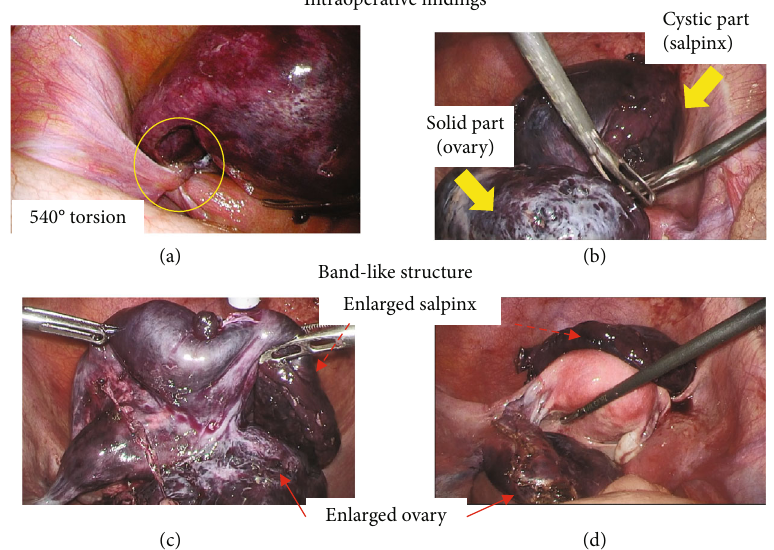
Figure 2: Intraoperative fi ndings. (a) Adnexal torsion was observed. (b) Two-follicular enlargement was observed. (c) A band-like structure was observed. (d) Left salpingectomy was performed. Arrows are as